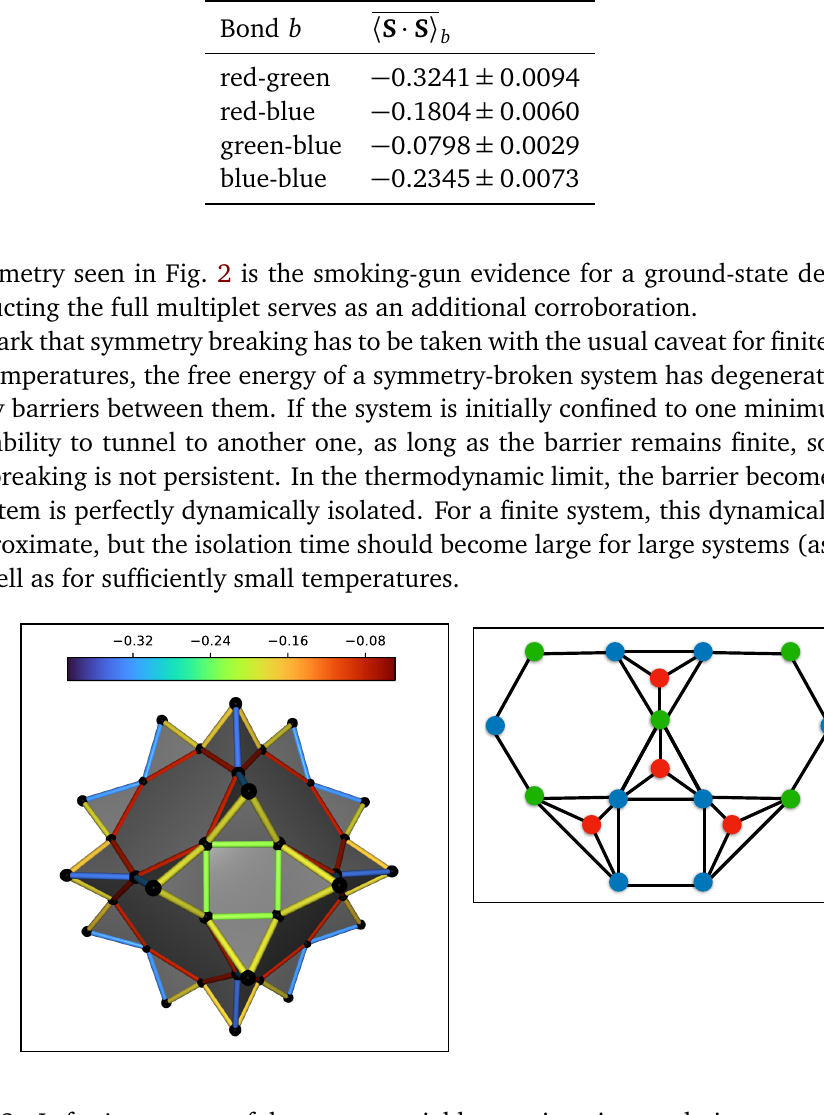
Figure 3: Left: An average of the nearest-neighbour spin-spin correlations across the three ground states via Eq. (6) restores the spatial symmetry. Right: Neighbourhood of a tetrahedron for reference. The colour conventions are as in Fig.